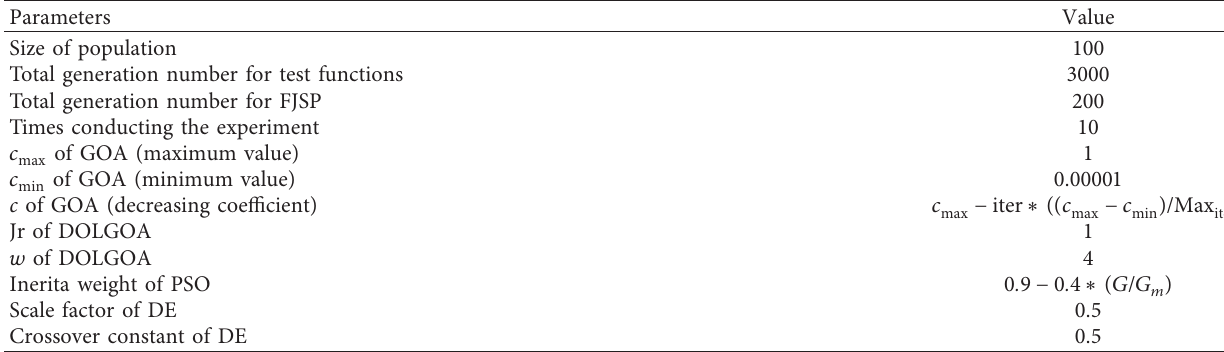
Table 2: The parameters settings of optimization